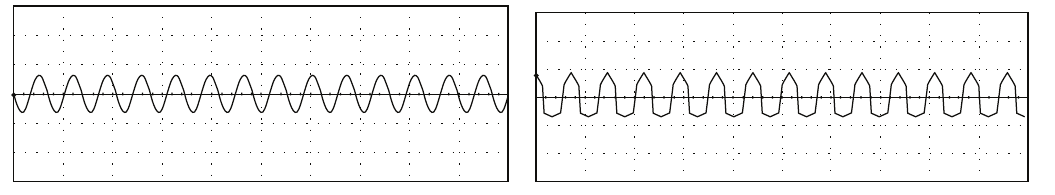
Figure 23: The waveform distortion contrast chart.